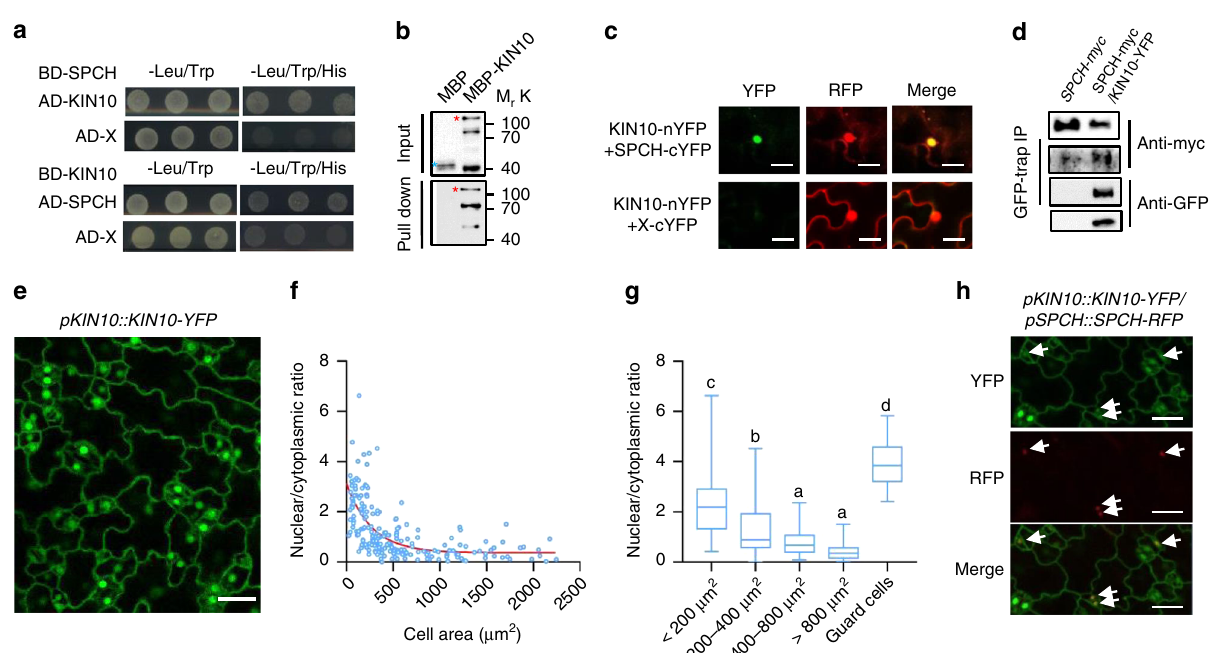
Fig. 4 KIN10 interacts with SPCH in vitro and in vivo. a KIN10 interacts with SPCH in yeast. b KIN10 directly interacts with SPCH in vitro. MBP and MBP- KIN10 were incubated with GST-SPCH bound to glutathione agarose beads and then eluted and analyzed by immunoblotting using anti-MBP antibody. Red asterisk indicated KIN10-MBP, while blue asterisk indicated MBP. c rBiFC showed that KIN10 interacts SPCH in tobacco leaves. d Coimmunoprecipitation assay of KIN10 and SPCH with seedlings expressing KIN10-YFP and SPCH-myc under 35S promoters or seedlings expressing only SPCH-myc. CoIP was performed using GFP-trap and immunoblotted using anti-GFP and anti-Myc antibodies. e The subcellular location of pKIN10::KIN10-YFP in Arabidopsis cotyledon epidermal cells. Seedlings of pKIN10::KIN10-YFP were grown in ½ MS liquid medium containing 1% Sucrose for 3 days under long-day condition. Scale bar, 20 μ m. f, g Quanti fi cation of nuclear localization of KIN10 in different scale epidermal cells of ( e ). Nuclear and cytoplasmic KIN10-YFP signal from more than 200 epidermal cells in 10 cotyledons were analyzed by ImageJ software. Scatter plot ( f ) and box plot ( g ) showed negative relationship of KIN10-YFP nuclear/cytoplasmic ratio and the size of epidermal cells. Error bars indicate standard deviation (S.D.). Different letters above the bars indicated statistically signi fi cant differences between the samples (ANOVA analysis followed by Uncorrected Fisher ’ s LSD multiple comparisons test, p < 0.05). h Co-localization of pKIN10::KIN10-YFP and pSPCH::SPCH-RFP in cotyledon epidermal cells. The seedling was grown in ½ MS liquid culture containing